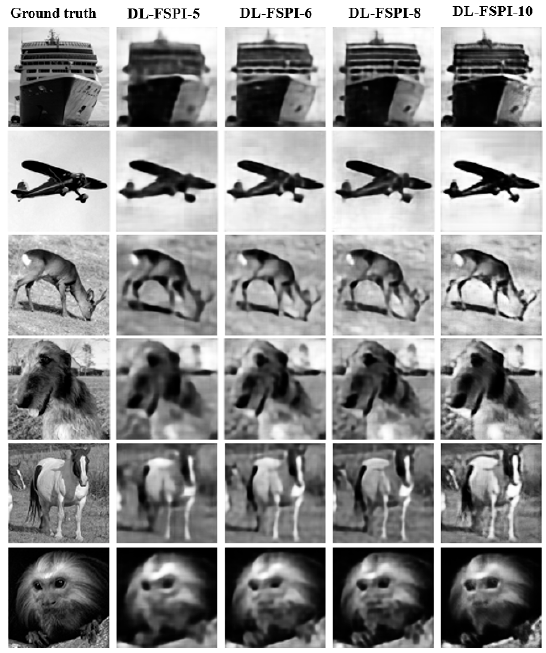
Figure 5. DL-FSPI reconstruction on validation dataset for 5%,6%, 8%, and 10% sampling rates.